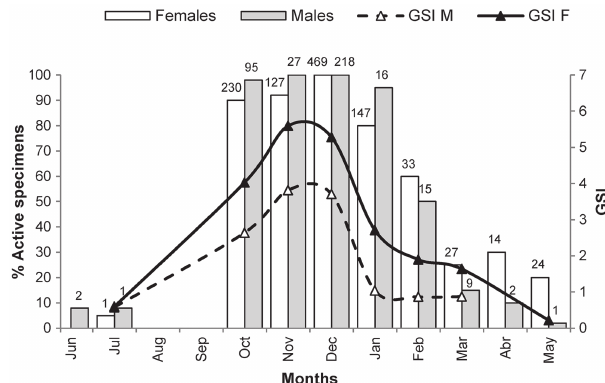
Fig. 2. Mean monthly gonadosomatic index (GSI) and monthly percent frequency of active males (M) and females (F) of Pagrus pagrus .